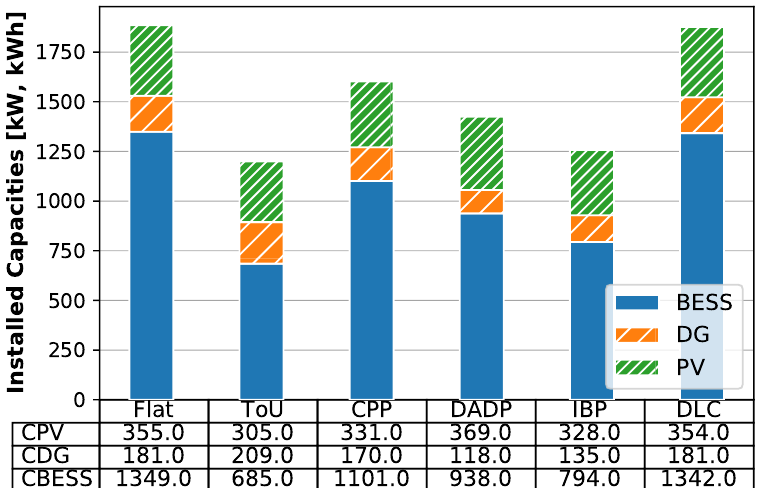
Figure 10. Comparison of the sizing of the energy sources for the DSM against the base case. Diesel Generator and photovoltaic capacities are in kW, and the Battery Energy Storage System (BESS) capacity is in